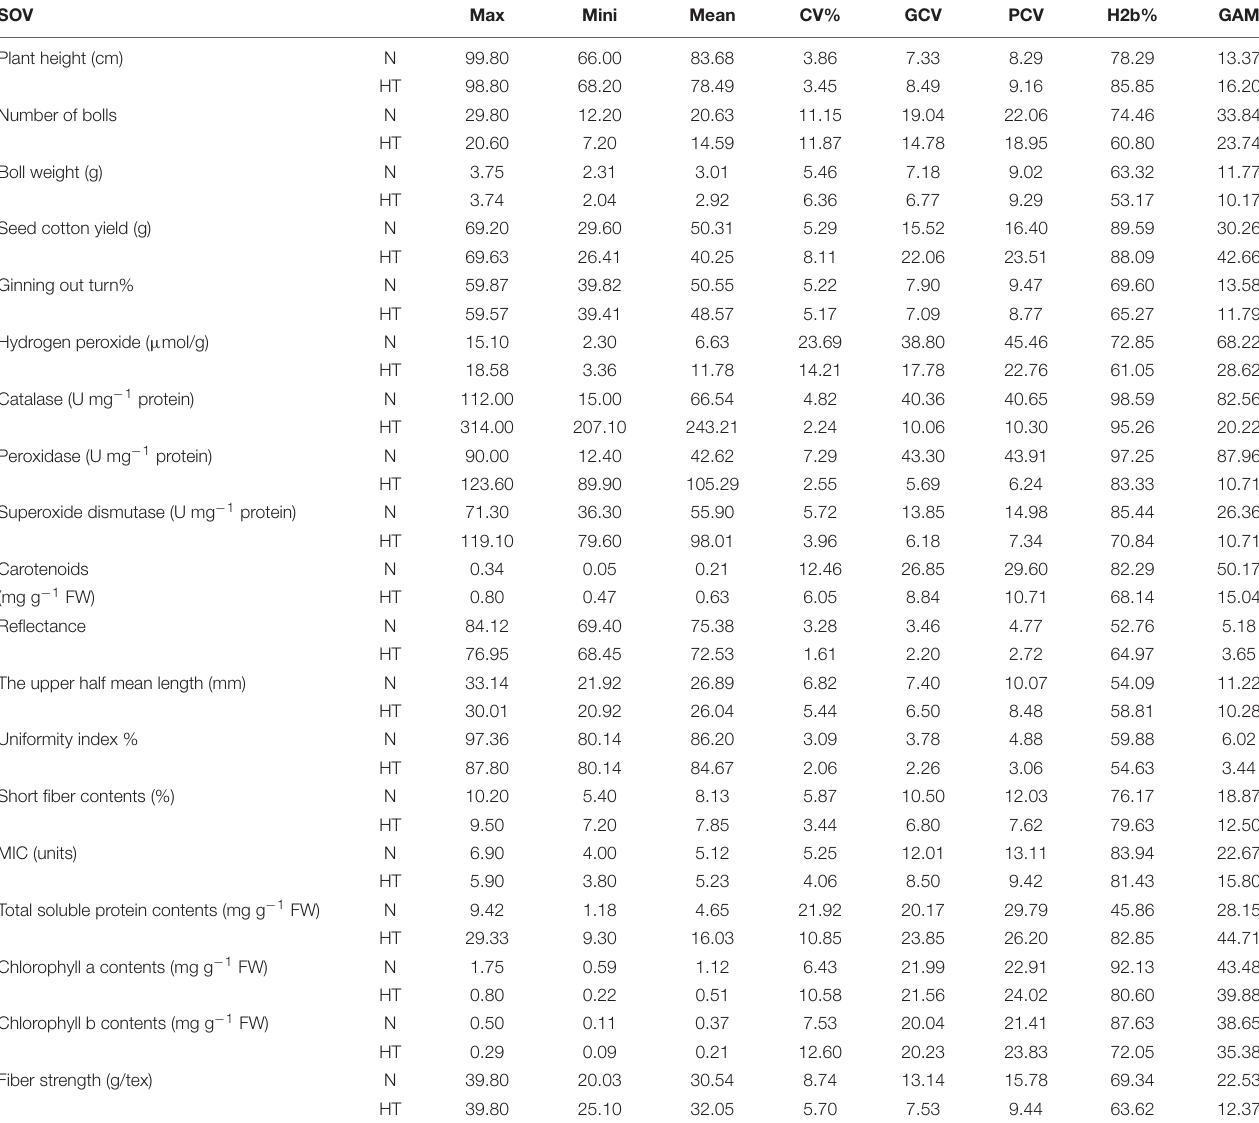
TABLE 3 | Genetic components of variability, genetic advance percentage means, and heritability (broad sense) estimate studied traits across normal (N) and heat stress (HT) conditions for pooled data across the years 2018 and 2019.